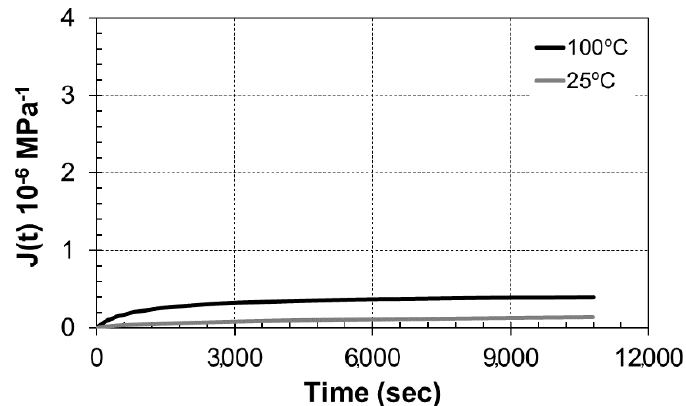
Figure 19. Creep compliance as a function of time for a nanocomposite made of 15 v% cellulose and 0 wt. % STO nanoparticles.